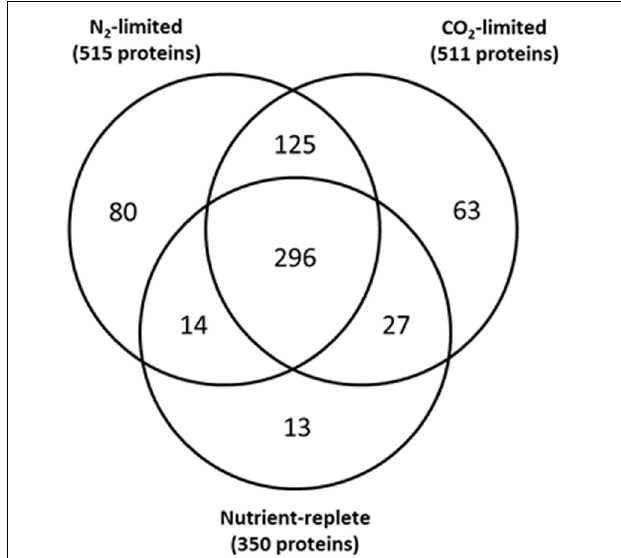
FIGURE 4 | Overlap of probe labeled proteins under nutrient-replete conditions, C-limited conditions, and N-limited conditions.